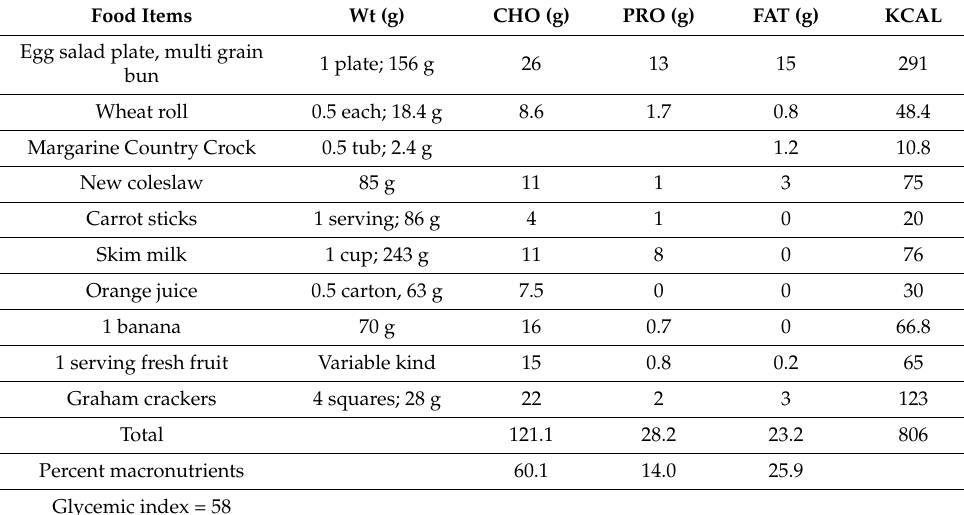
Table 2. Food items, macronutrients, and calories in the morning meal.